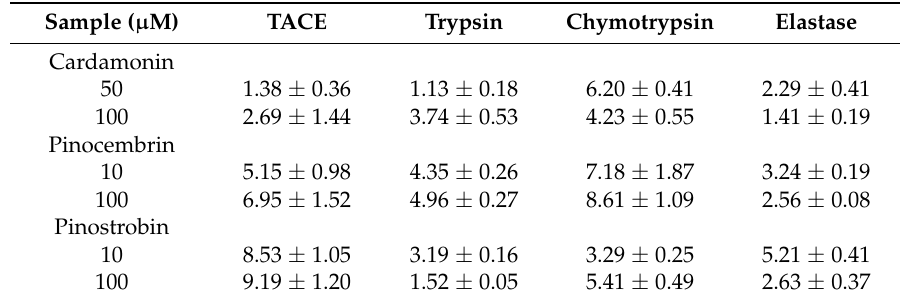
Table 2. Inhibitory activities (%) of cardamonin, pinocembrin, and pinostrobin against α -secretase (tumor necrosis factor- α converting enzyme, TACE) and other serine